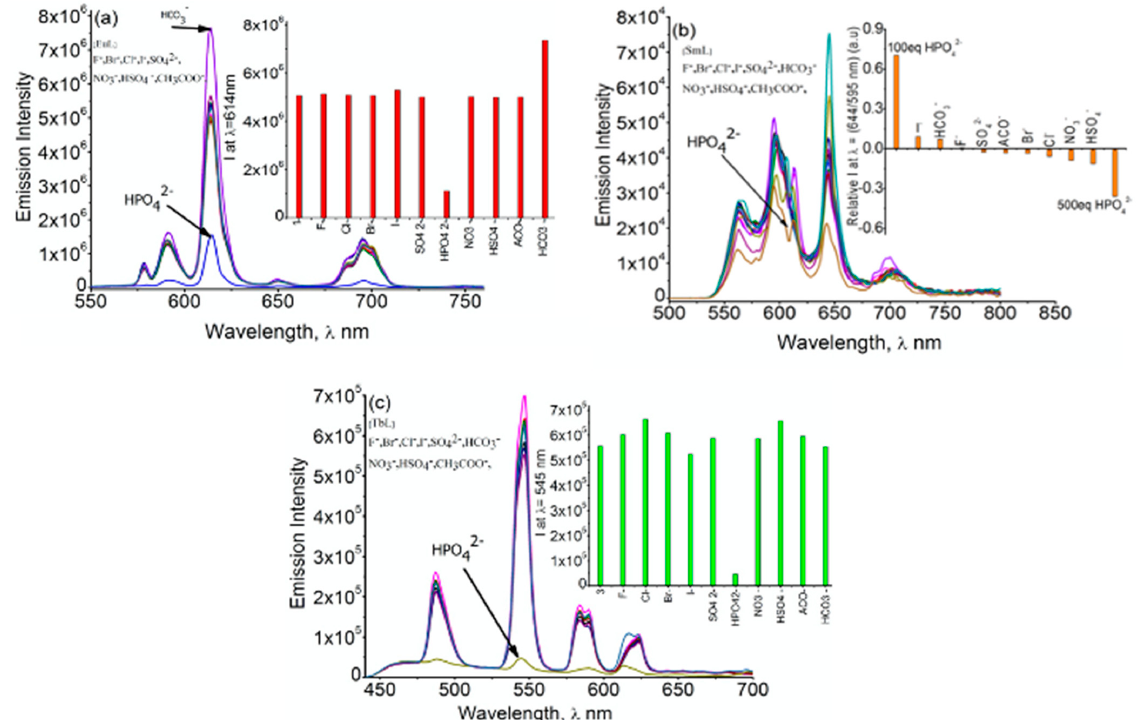
Figure 1. Emission spectra of ( a ) 1 (1 × 10 − 5 M), ( b ) 2 (2 × 10 − 5 M), and ( c ) 3 (4 × 10 − 5 M) upon the addition of various anions (100 equiv. for 1 and 10 equiv. for 3 in aqueous HEPES (2-[4-(2-hydroxyethyl)piperazin-1-yl]ethanesulfonic acid) buffer at pH = 7.4, λ exi = 276 nm): in the case of 2 , spectra obtained after the addition of both 100 (cyano) and 500 equiv. (light brown) of HPO 42 − are overlaid. Insets: luminescence intensities of 1 and 3 at 614 and 545 nm, respectively, in the presence of different anions, while in the case of 2 , relative intensity ratios (644/595 nm) are plotted along the